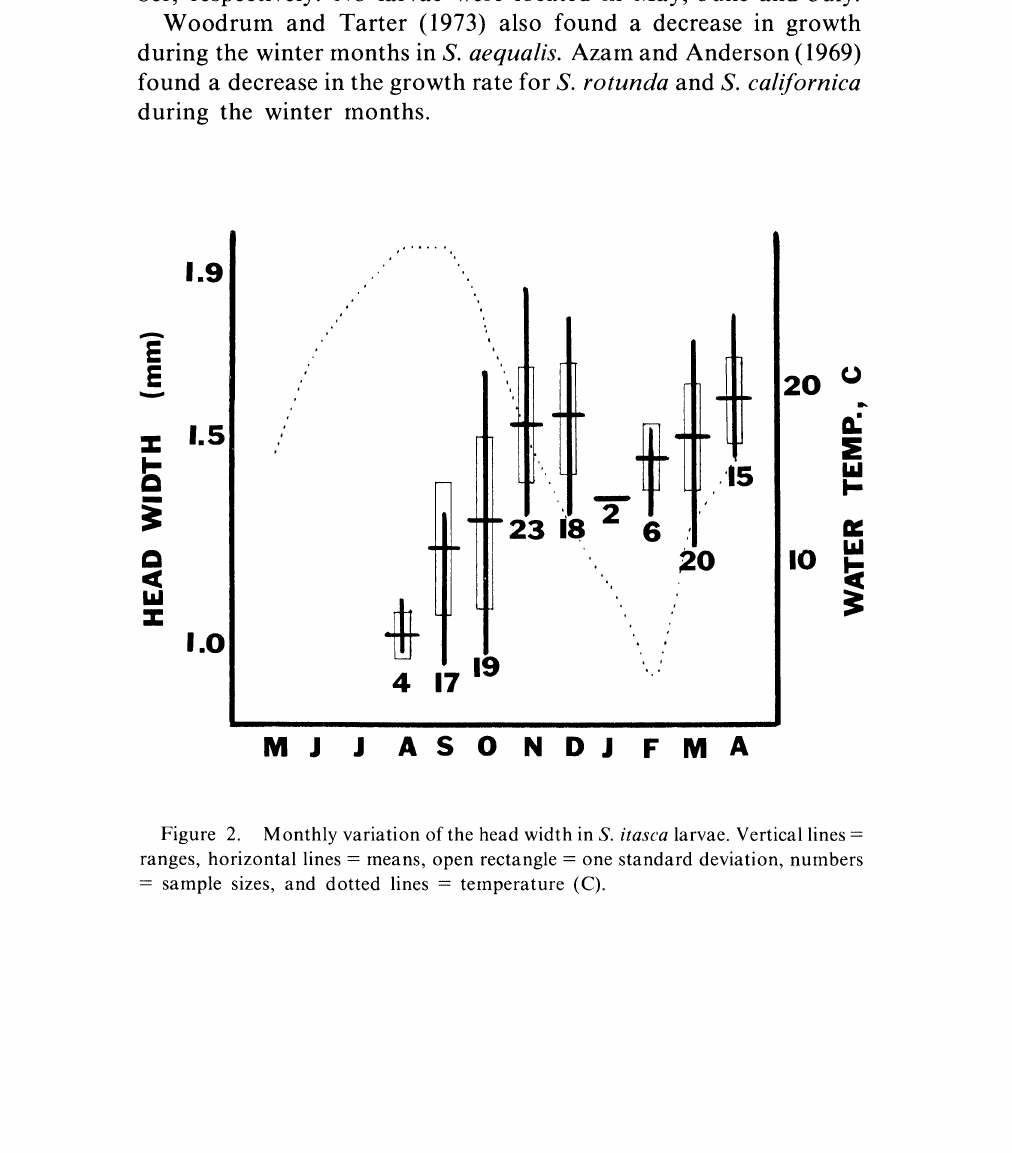
Figure 2. Monthly variation of the head width in S. itasca larvae. Vertical lines ranges, horizontal lines means, open rectangle one standard deviation, numbers sample sizes, and dotted lines temperature